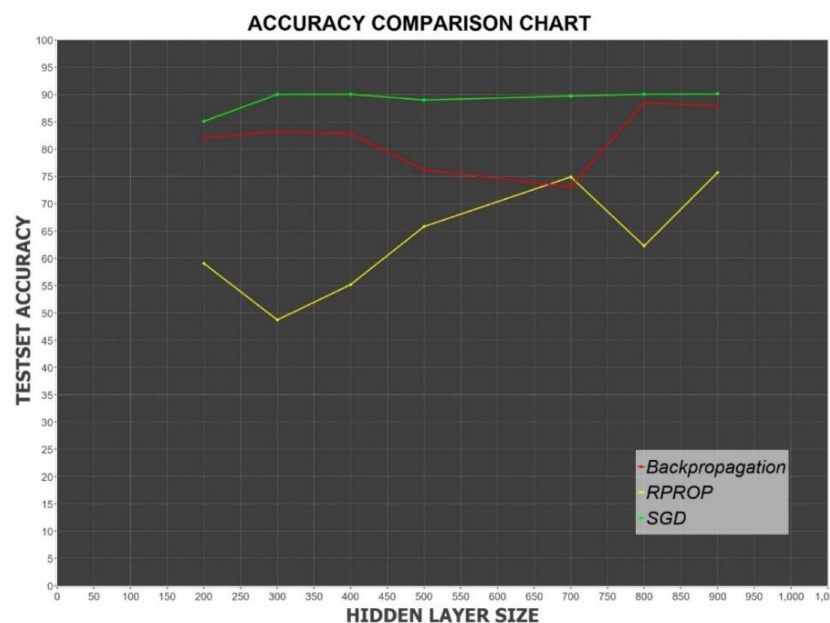
Figure 9. Comparison of backpropagation-RPROP-SGD testset accuracies of Table 1.